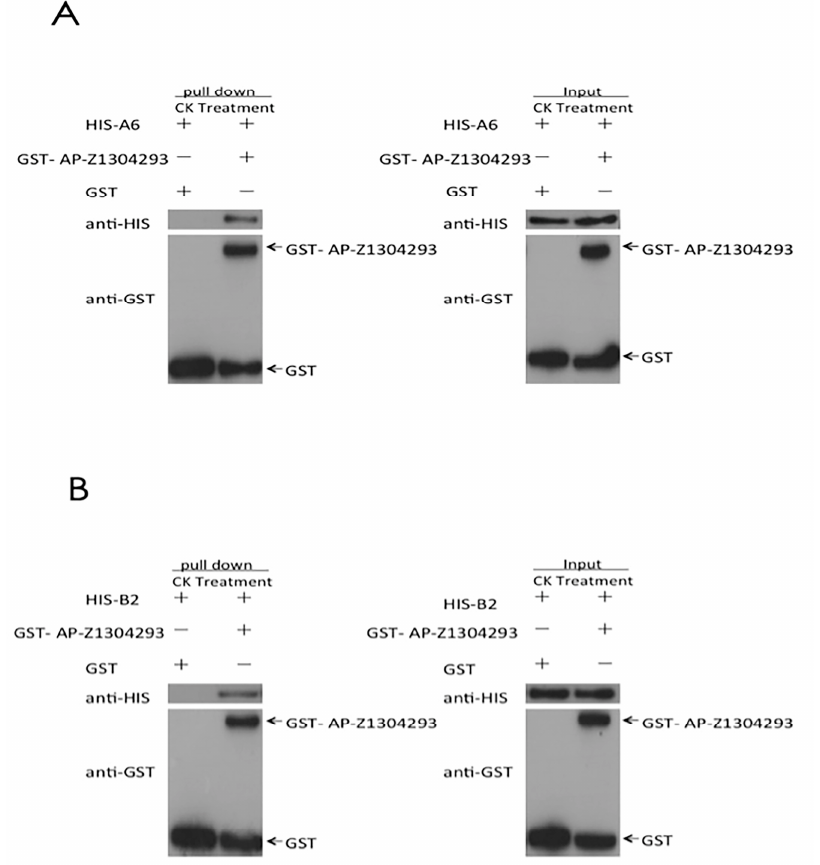
Figure 4. GST pull-down results of the target proteins B2 and DnaJ. Note: ( A ): interaction between ApCE22 and DnaJ. ( B ): Interaction between ApCE22 and B2. Pull-down is the protein electrophoresis result of the eluent obtained after the DnaJ protein solution passes through the GST column. Input is the protein electrophoresis result of the DnaJ protein solution without passing through the GST column.